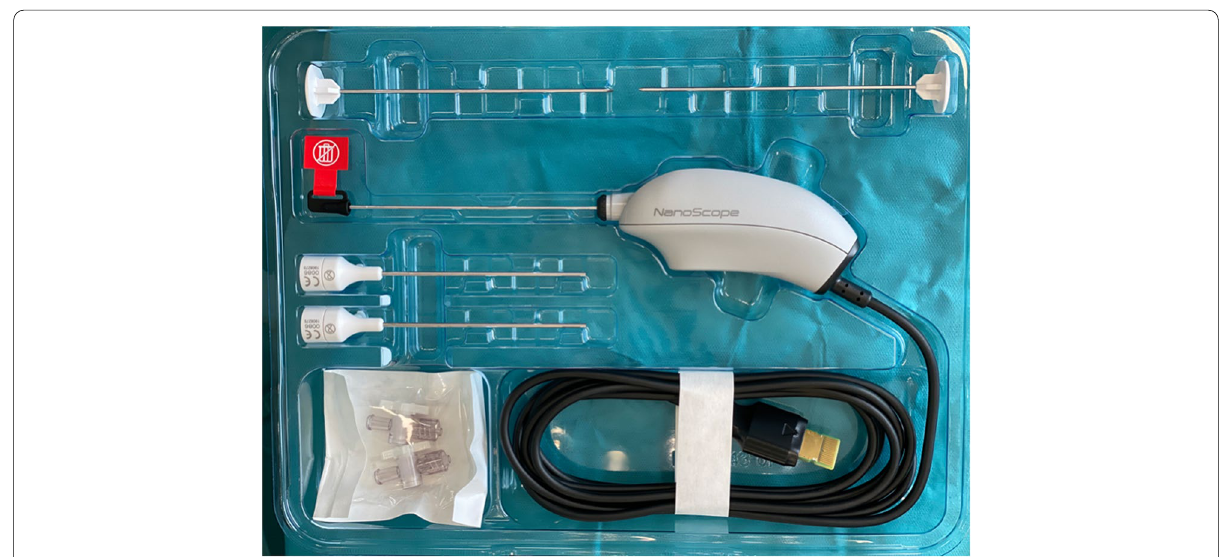
Fig. 2 NanoScopeTM video system: handpiece provided in a single-use